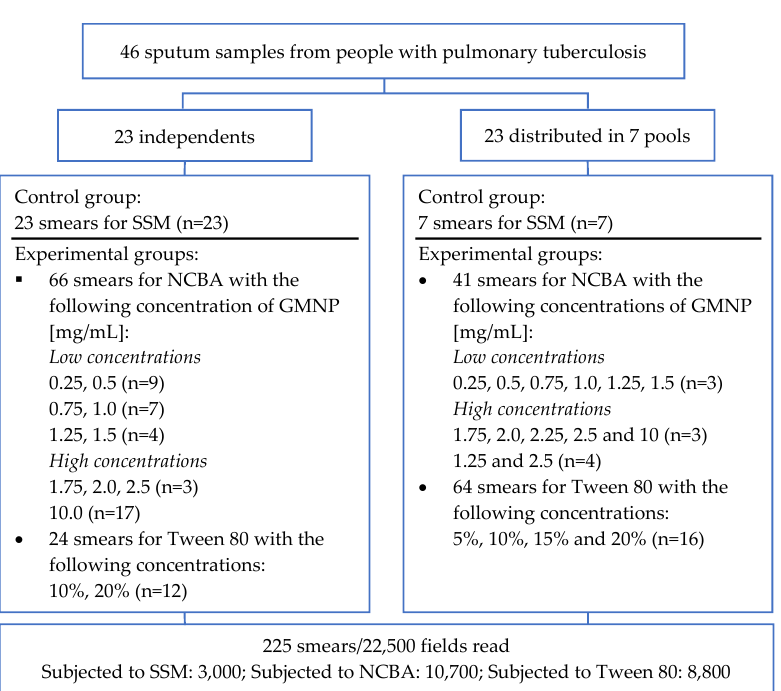
Figure 2. Flow diagram of the clinical samples analyzed and the experimental tests performed. GMNP: glycan-functionalized magnetic Nanoparticles; NCBA: magnetic nanoparticle-based colori- metric biosensing assay; SSM: sputum smear microscopy. The number of aliquots used for each of the smears analyzed by SSM and different NCBA or Tween 80 concentrations are shown in